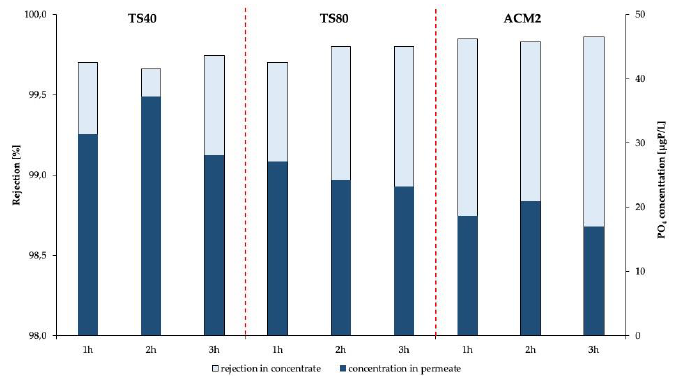
Figure 4. The determination of phosphate traces of antiscalant in membrane permeates of NF mem- branes TS40 and TS80 and RO membrane ACM2. Feed concentration antiscalant 10